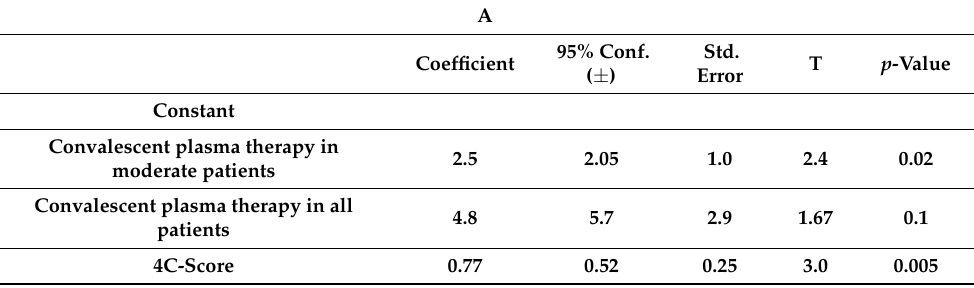
Table 3. The effect of the convalescent plasma on the hospitalization length ( A ) and the time to negative PCR ( B ) in moderate patients. SE are the standard errors of the regression coefficients. T is the quotient of the coefficient. Two-sided p values or observed significance